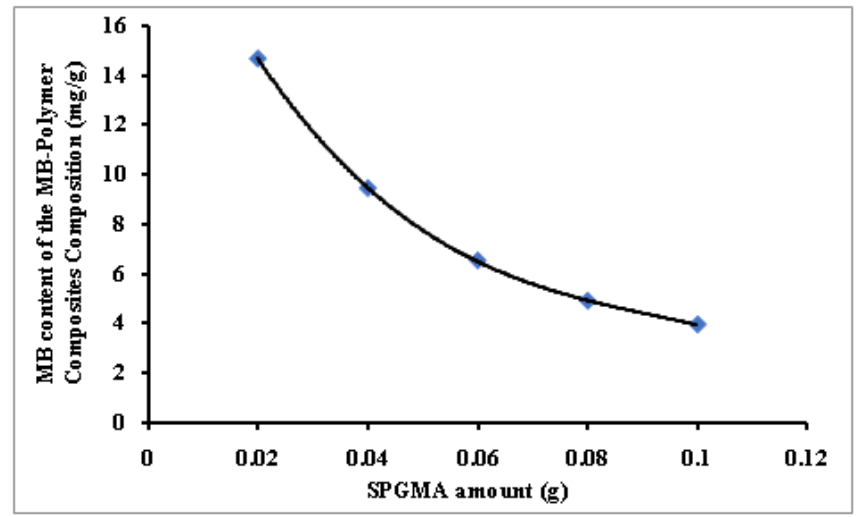
Figure 3. Effect of the SPGMA polymer dosage on the MB content of the MB-SPGMA composites composition.